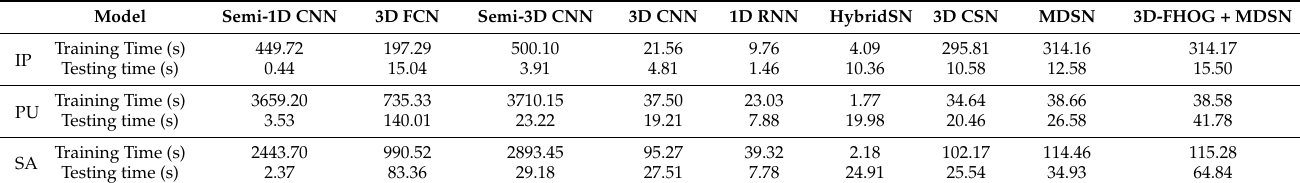
Table 11. Running time of different methods on the three HSI data sets with three labeled samples per class.